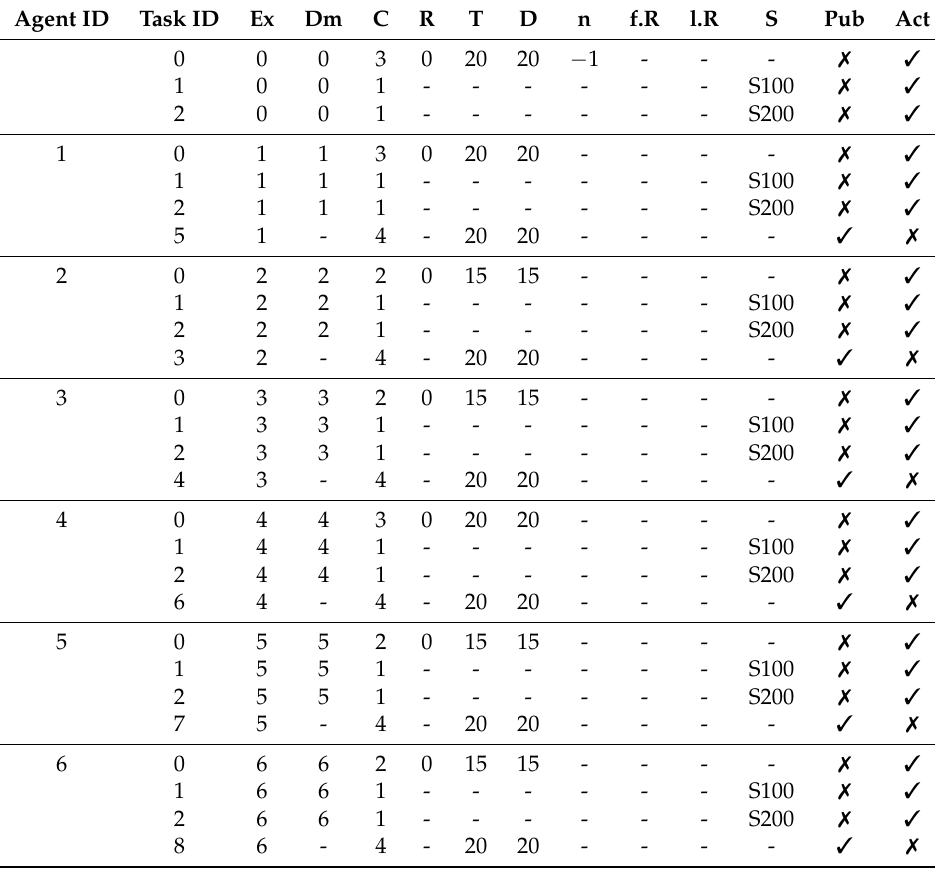
Table 6. Agents’ task-set for Scenario S2.